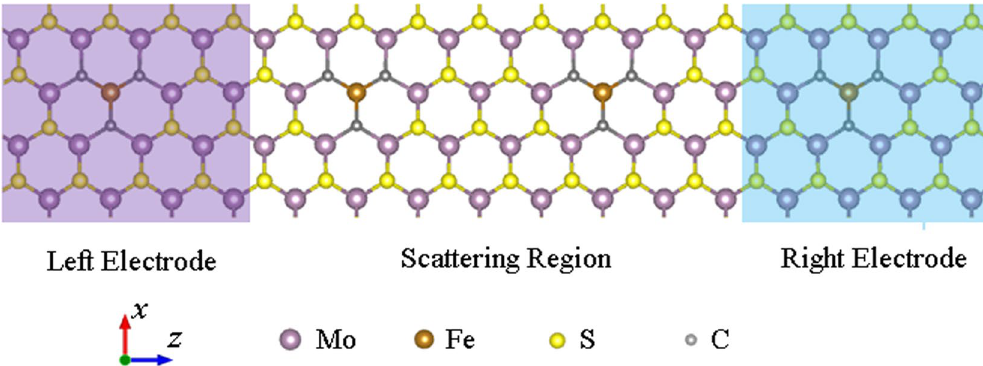
Figure 1. Schematic illustration of two-probe system. Schematic illustration of Fe-C 6 cluster doped monolayer MoS 2 two-probe